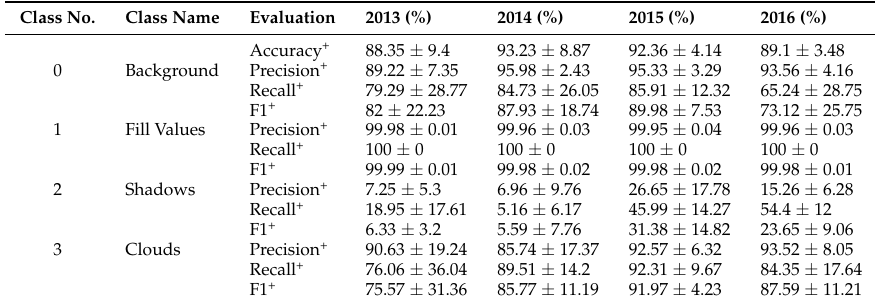
Table 4. Average scores of accuracy, precision, recall, and F1 of Refined UNet on cross-validation of the four-year image